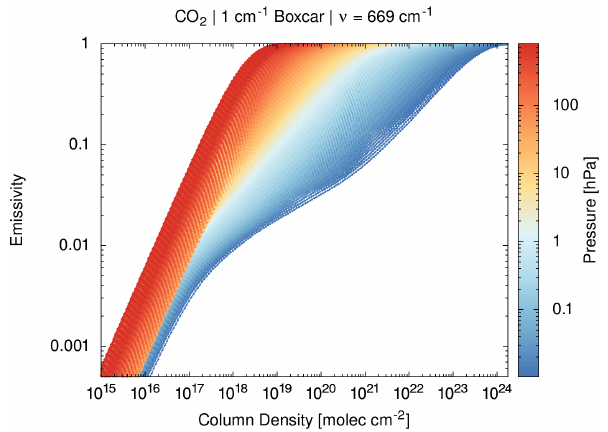
Figure 2. Log–log plot of spectral mean emissivity curves for car- bon dioxide (CO 2 ) at 669cm − 1 and for a 1cm − 1 boxcar spectral response function. The curves have been calculated for different pressure levels (see color coding) and temperature values (not high- lighted). Small dots along the emissivity curves illustrate the dense sampling of the look-up table